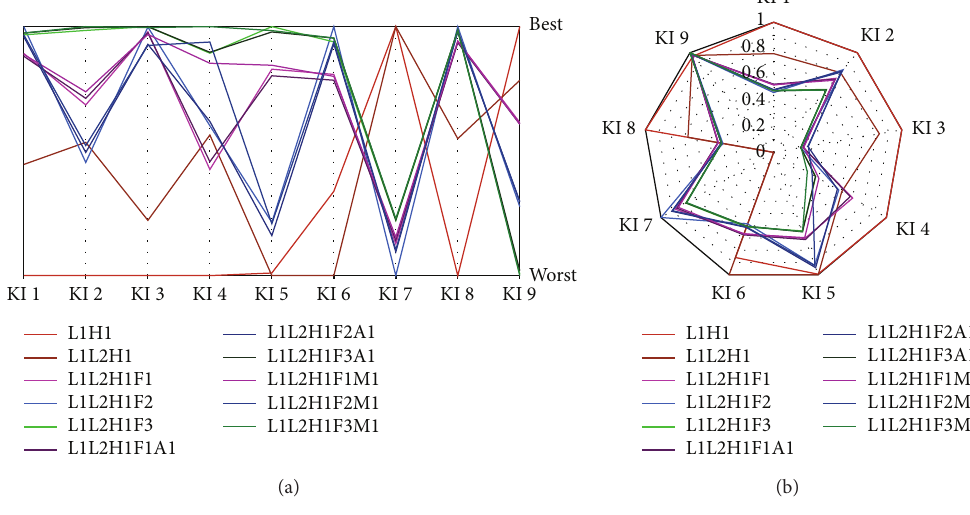
Figure 2: Value path (a) and radar chart